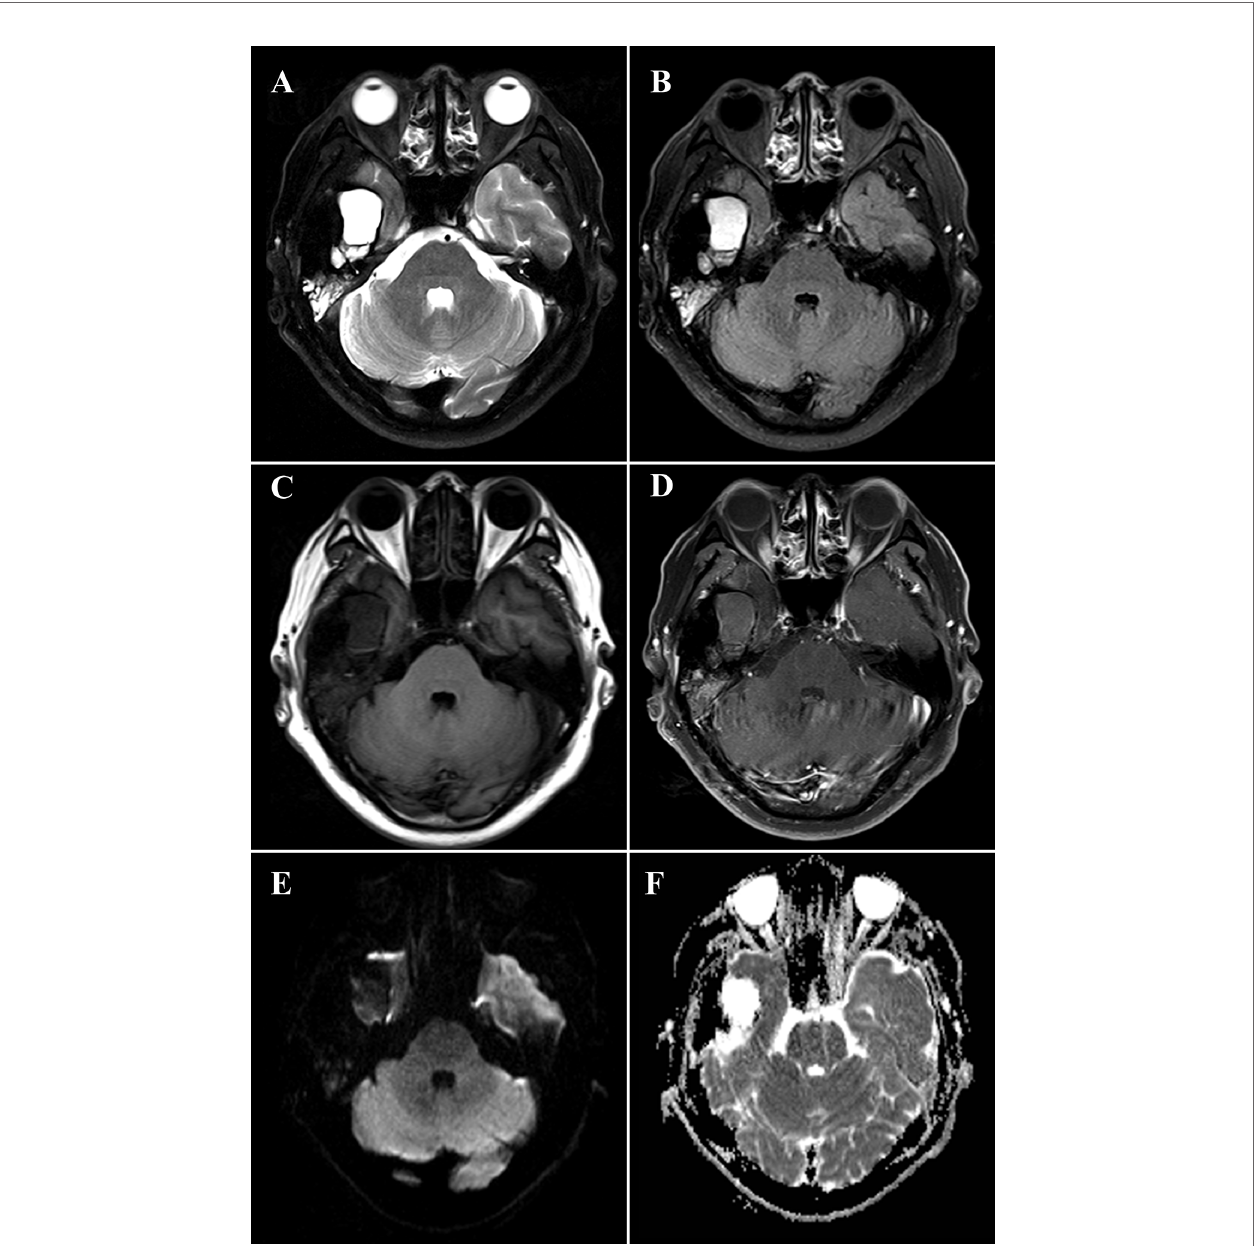
FIGURE 2 | Magnetic resonance imaging (MRI) of a 48-year-old man with diffuse tenosynovial giant cell tumor (D-TSGCT) in right temporomandibular joint (TMJ). MRI reveals a predominantly hypointense lesion with focal cystic changes on T2-weight imaging (A) , fl uid-attenuated inversion recovery (FLAIR) sequence (B) and T1-weighted imaging (C) , which in fi ltrates the medial cranial fossa. Mild enhancement at the wall of the cystic part and no enhancement of the solid part was observed after administration of contrast agent (D) . The lesion is hypointense on diffusion-weighted imaging (DWI) (E) and displays heterogeneous intensity on the apparent diffusion coef fi cient (ADC) map (F)